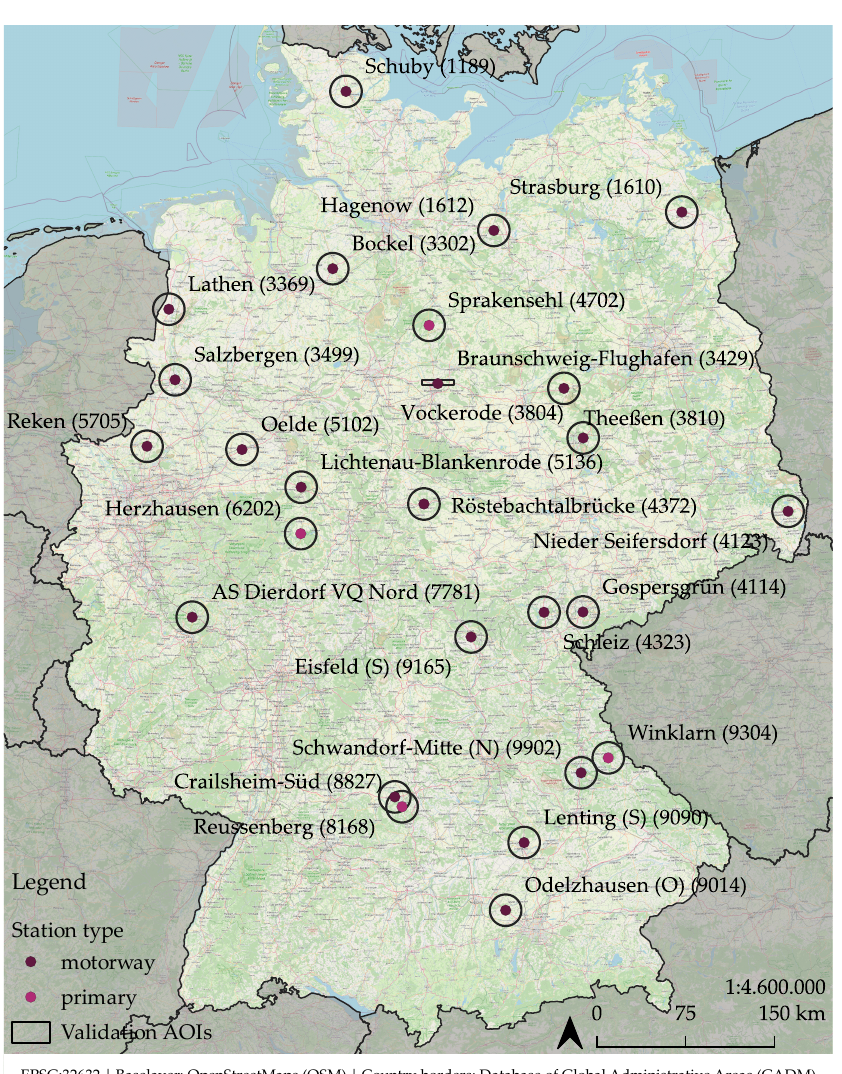
Figure A1. Locations of selected BAST traffic count stations and validation areas. Circles show the buffered AOIs. The Braunschweig-Flughafen AOI is rectangular to avoid covering adjacent